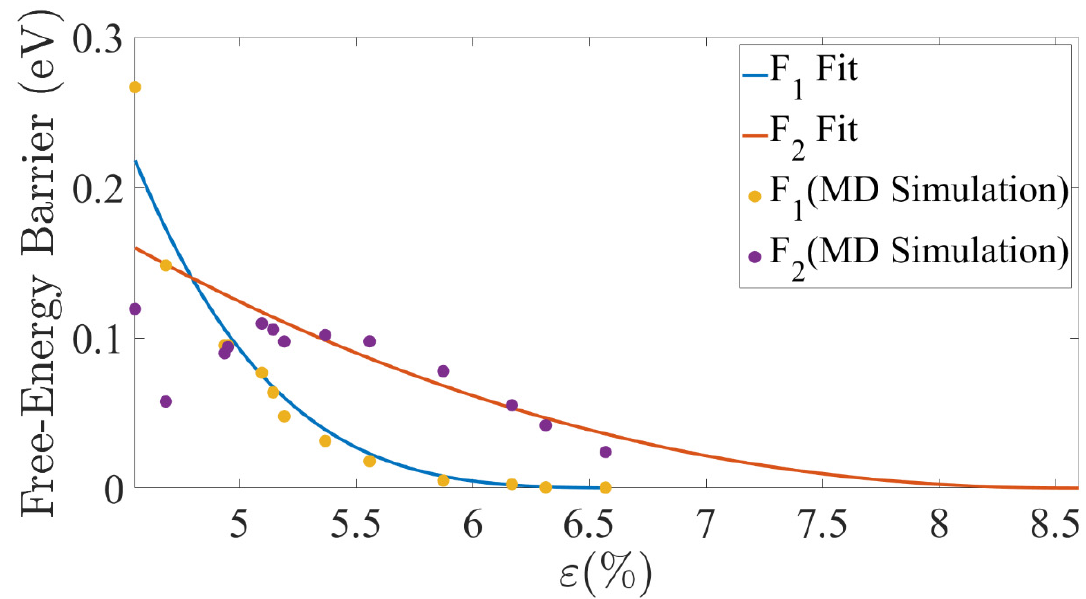
15 of 24 Figure 8. Temperature ‐ independent part of the free energy barrier 𝑄 (cid:2869) as a function of (cid:3435) 1 (cid:3398) 𝜀 𝜀 (cid:3030)(cid:3045) (cid:3117) ⁄ (cid:3439) . 3.3.3. Finding the Free ‐ Energy Barriers Since we can neglect the activation entropy, 𝐹 (cid:2869) is a function of the strain only, i.e., 𝐹 (cid:2869) (cid:3404) 𝑄 (cid:2869) . Accordingly, the values plotted in Figure 9 for 𝑄 (cid:2869) (cid:4666)𝜀̅(cid:4667) as a function of 𝜀̅ are also the values of the free ‐ energy barrier. Therefore, we can fit a function 𝑄 (cid:2869) (cid:4666)𝜀(cid:4667) for the results, to find the dependence of the free ‐ energy barrier on the strain. In previous studies, a power law was argued to fit the activation energy near the spontaneous nucleation thresh ‐ old. Thus, we fit a function of the form